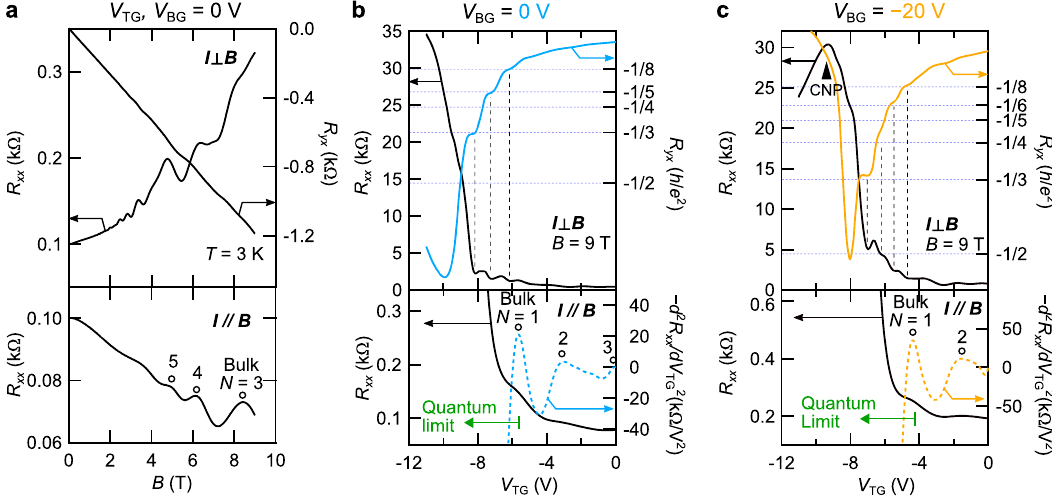
Fig. 2 Quantum transport of a 75 nm thick (Cd 1 − x Zn x ) 3 As 2 fi lm. a Field dependence of resistance R xx measured in transverse fi eld ( I ⊥ B , upper panel) and longitudinal fi eld ( I ∥ B , lower panel) con fi guration at V TG , V BG = 0 V. The right axis shows Hall resistance R yx . b , c V TG scans of R xx (upper panel for I ⊥ B , lower panel for I ∥ B ) and R yx measured at B = 9 T with V BG set to 0 V ( b ) and − 20 V ( c ). To clearly present the bulk oscillations, the second derivatives of R xx with respect to V TG are also shown on the right axis of the lower panels. Quantum Hall plateaus clearly develop as the bulk state reaches the quantum limit. A carrier type inversion is induced as the fi lm is depleted across the charge neutrality point (CNP) in c